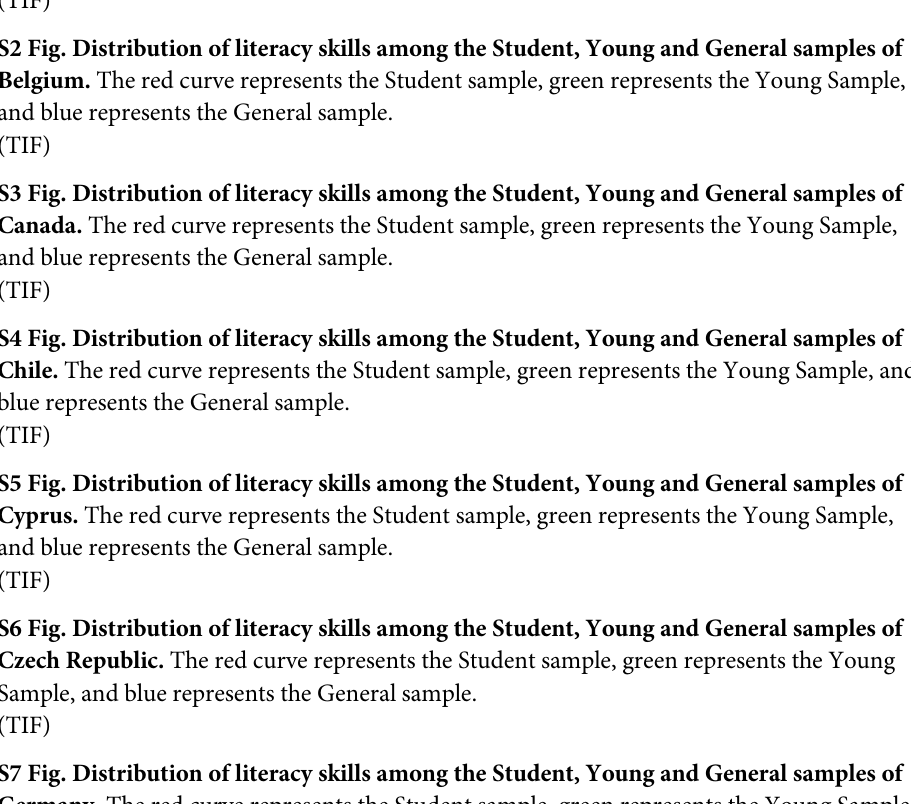
S1 Fig. Distribution of literacy skills among the Student, Young and General samples of Austria. The red curve represents the Student sample, green represents the Young Sample, and blue represents the General sample. S2 Fig. Distribution of literacy skills among the Student, Young and General samples of Belgium. The red curve represents the Student sample, green represents the Young Sample, and blue represents the General sample. S3 Fig. Distribution of literacy skills among the Student, Young and General samples of Canada. The red curve represents the Student sample, green represents the Young Sample, and blue represents the General sample. S4 Fig. Distribution of literacy skills among the Student, Young and General samples of Chile. The red curve represents the Student sample, green represents the Young Sample, and blue represents the General sample. S5 Fig. Distribution of literacy skills among the Student, Young and General samples of Cyprus. The red curve represents the Student sample, green represents the Young Sample, and blue represents the General sample. S6 Fig. Distribution of literacy skills among the Student, Young and General samples of Czech Republic. The red curve represents the Student sample, green represents the Young Sample, and blue represents the General sample. S7 Fig. Distribution of literacy skills among the Student, Young and General samples of Germany. The red curve represents the Student sample, green represents the Young Sample, and blue represents the General sample. S8 Fig. Distribution of literacy skills among the Student, Young and General samples of Ecuador. The red curve represents the Student sample, green represents the Young Sample, and blue represents the General sample. S9 Fig. Distribution of literacy skills among the Student, Young and General samples of Spain. The red curve represents the Student sample, green represents the Young Sample, and blue represents the General